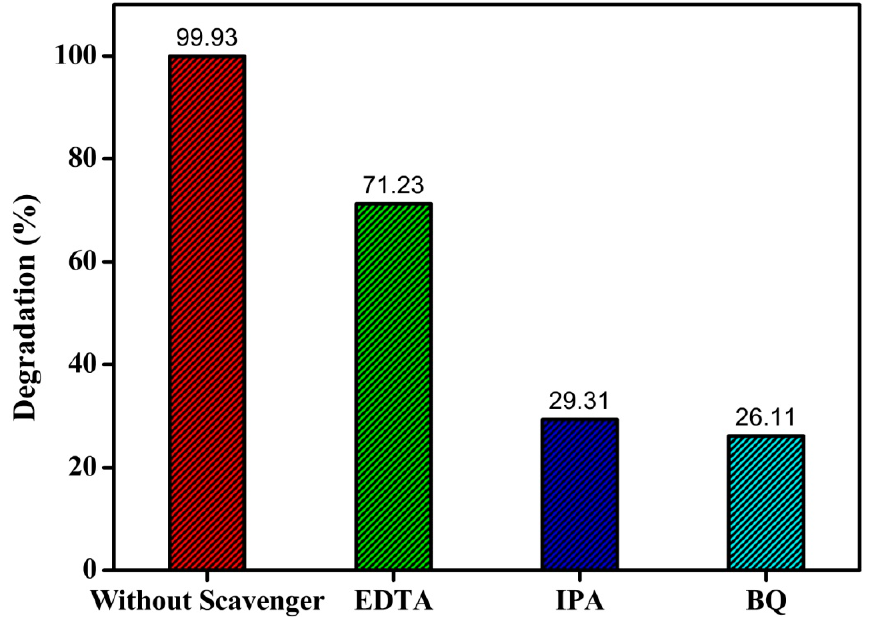
Figure 9. Effects of different scavengers on the photodegradation of MO in the presence of the TU4 under UV light.